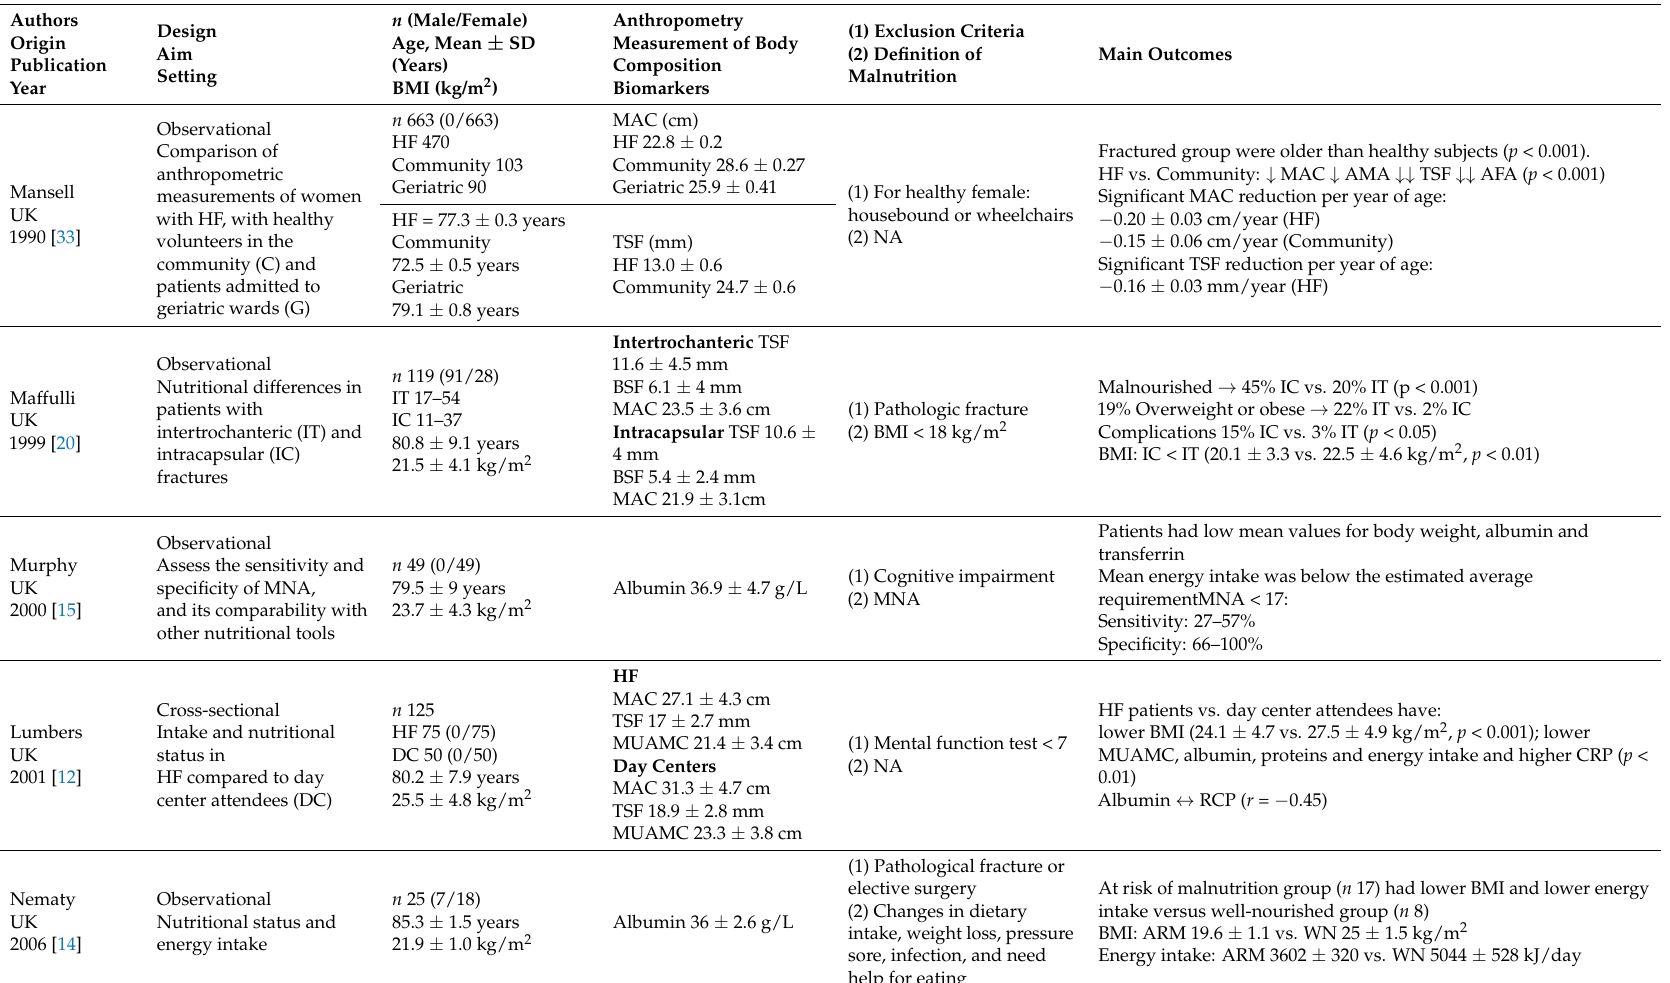
Table 2. Nutritional status and biomarkers in patients with hip